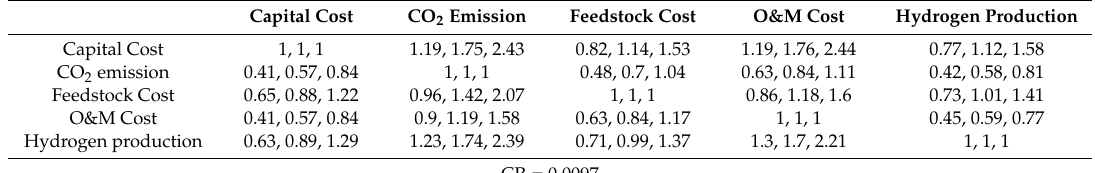
Table 4. Pairwise matrix of the fuzzy analytical hierarchy process (FAHP).